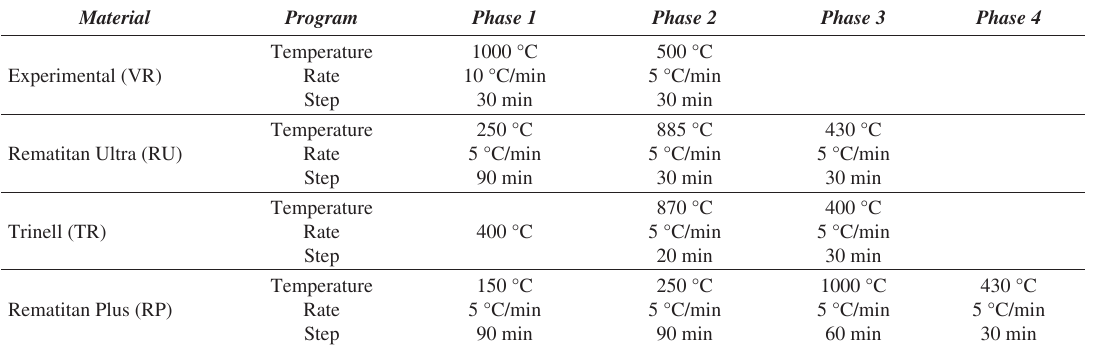
Figure 2. Casting for castability evaluation with incomplete cast Table 2. Heating program for investments studied.